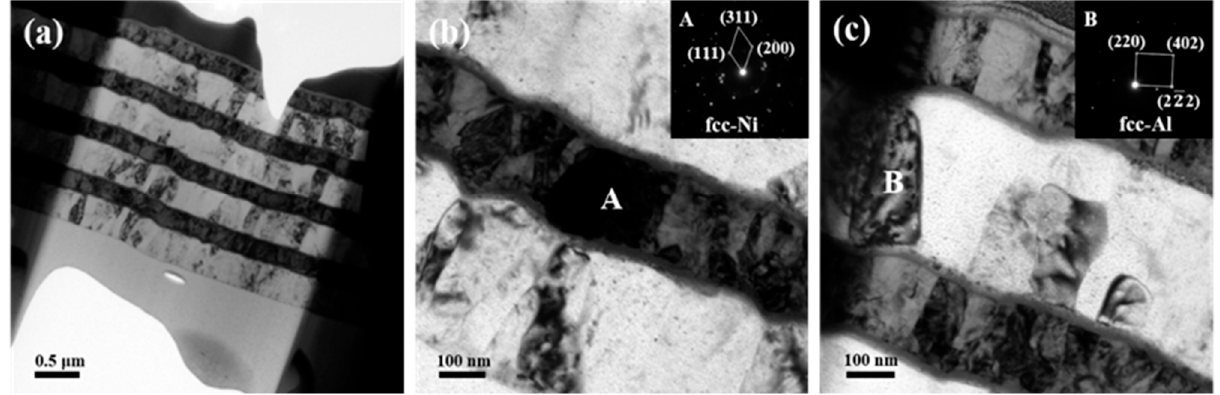
Figure 4. TEM images together with selected area electron diffraction patterns of the ATNT foil after annealing at 573 K for 3 h: ( a ) the whole morphology; ( b ) the bottom region; ( c ) the top region.